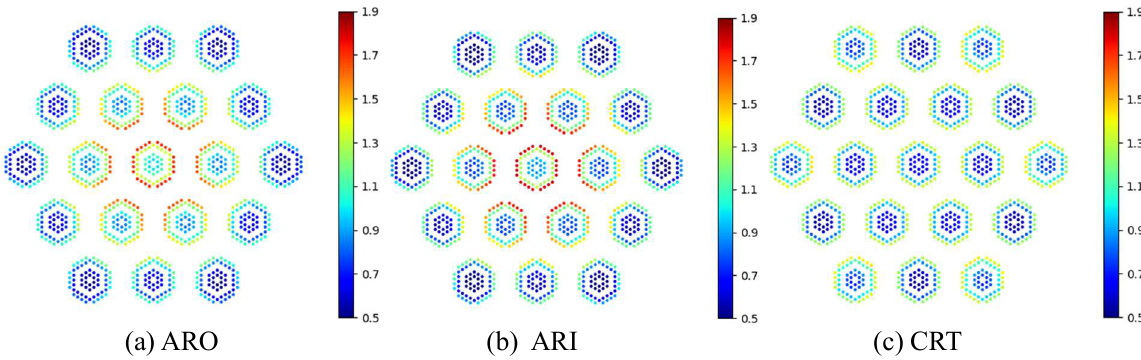
Figure 3. Normalized PFD distributions predicted by COMET. Table III. Comparison of the PFD distribution computed by COMET and